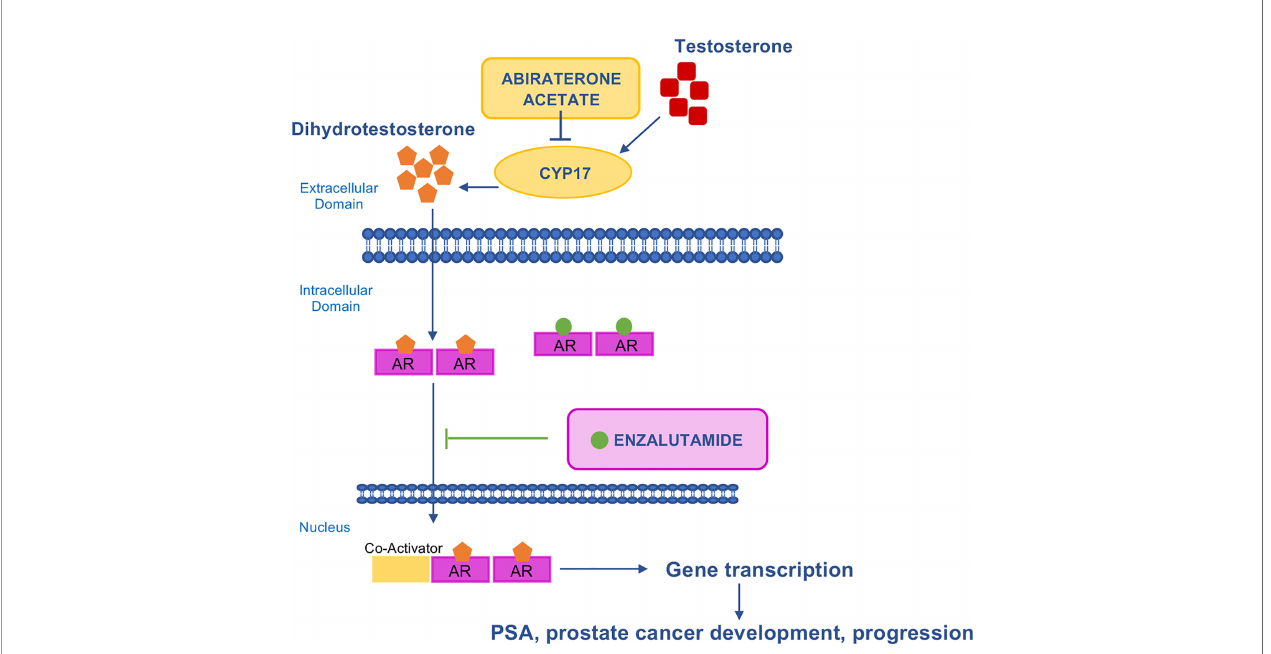
FIGURE 4 | Mechanism of action of AR – targeted drugs. AR is a transcription factor that is activated by androgenic hormones binding. Upon activation, AR translocates into the nucleus where it activates the transcription of genes involved in cancer development and progression. Abiraterone acetate inhibits CYP17, the enzyme responsible for the conversion of testosterone to dihydrotestosterone. Enzalutamide is a potent, competitive binder of androgens at the AR. It prevents the translocation of the AR from the cytoplasm to the nucleus. AR, androgen receptor; CYP17, 17 a – hydroxilase/C17,20 – lyase; PSA, prostate – speci fi c antigen.